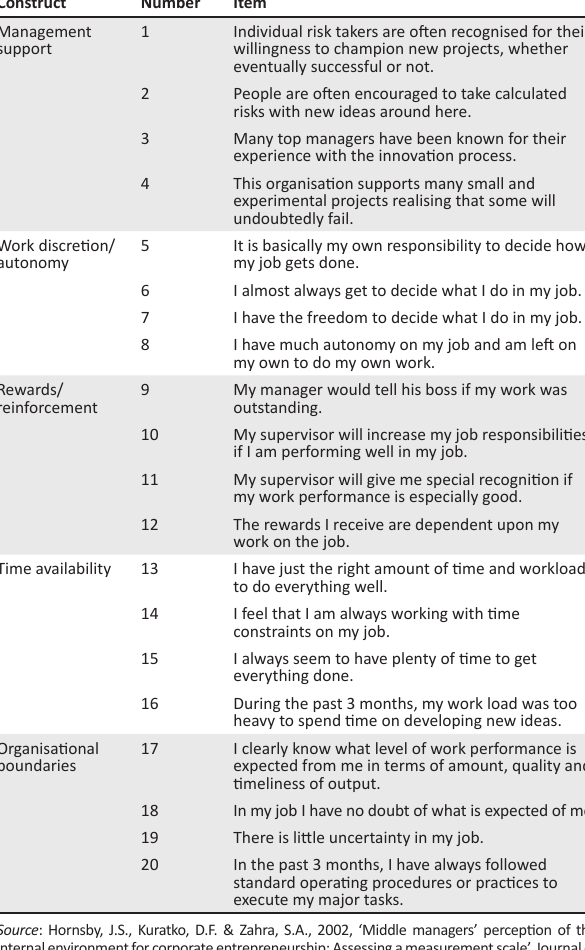
TABLE 1: Constructs and items of the Brief Corporate Entrepreneurship Assessment Instrument.